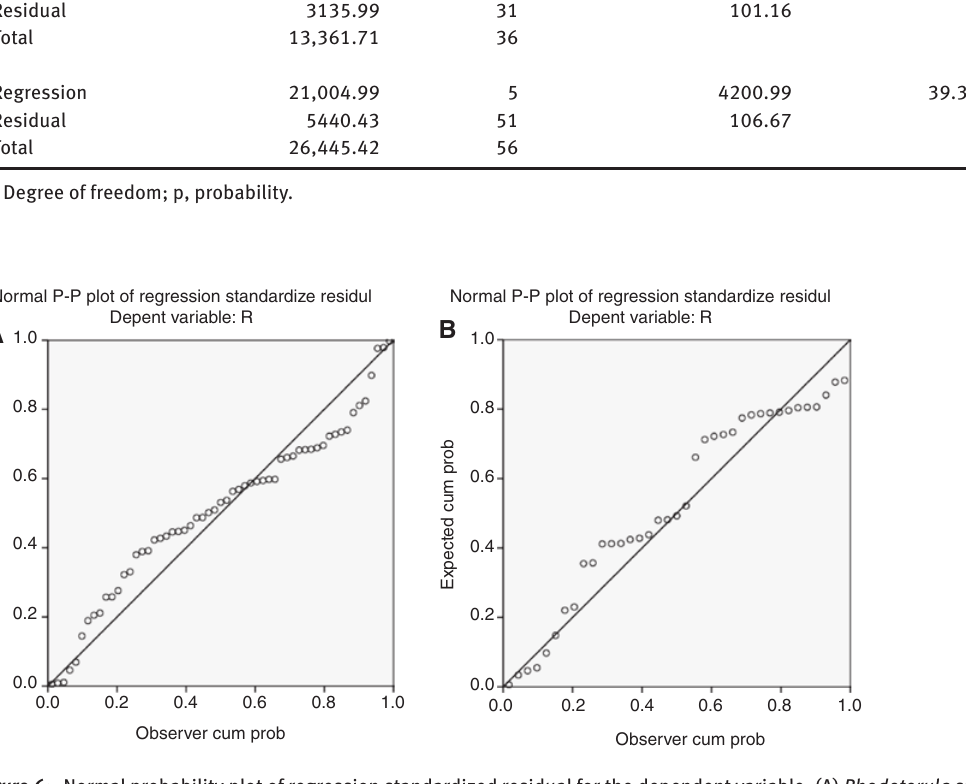
Figure 6: Normal probability plot of regression standardized residual for the dependent variable: (A) Rhodotorula sp. and (B) Bacillus megaterium